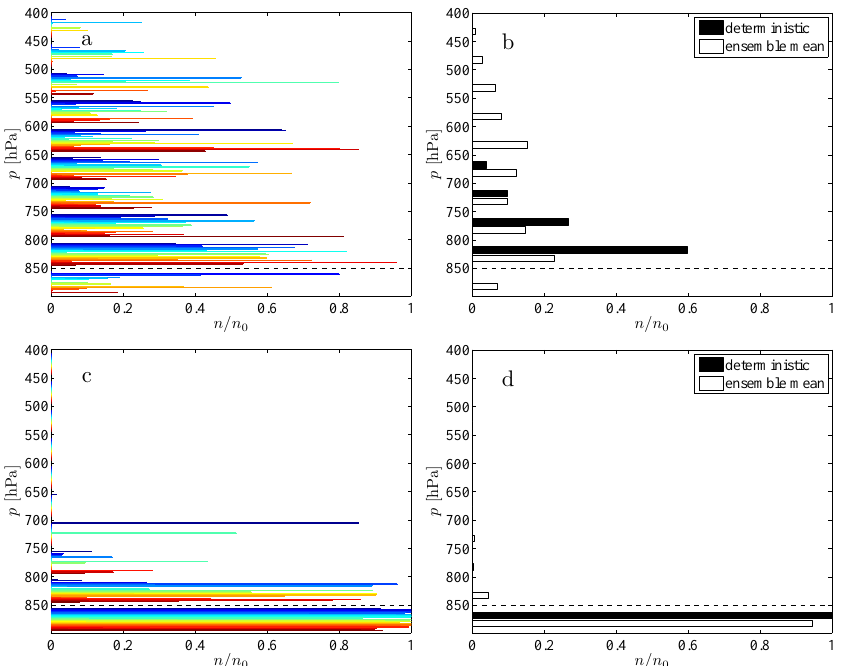
Fig. 3. The vertical distribution of the particles of r = 1µm (a, b) and r = 4µm (c, d) after 2.5 days coarse-grained in 10 layers. Colors in (a) and (c) indicate the 50 ensemble members; black and white in (b) and (d) mark the deterministic forecast and the ensemble mean, respectively. The black dashed lines illustrate the bottom level of the simulation range. n/n 0 denotes the proportion of particles in a given layer within a single forecast ( n 0 = 90000 ).